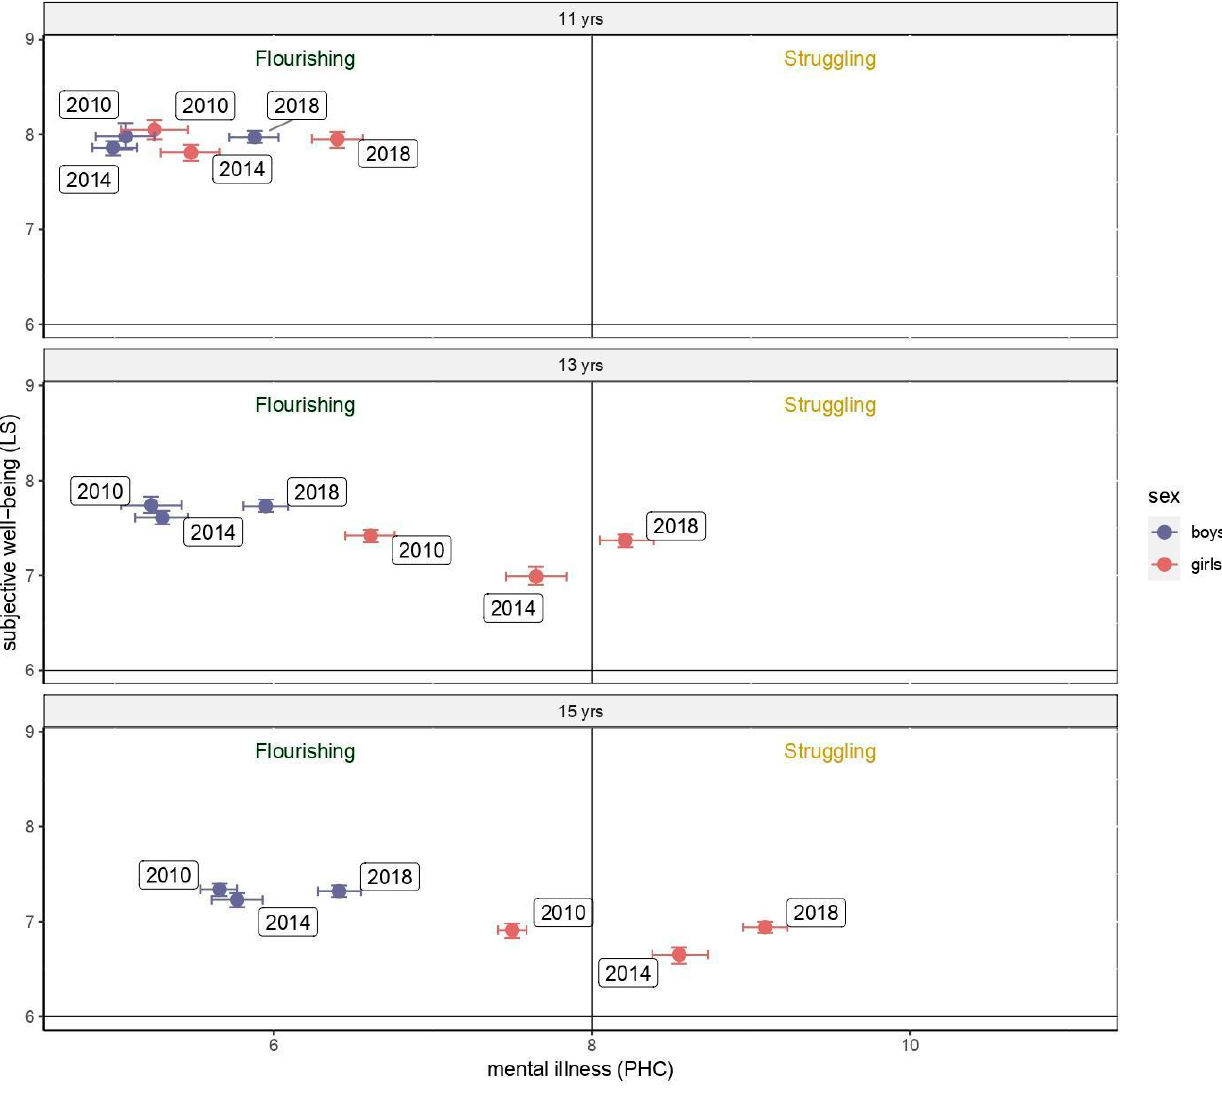
Figure 2. Change over time of the placement of the gender-age groups in the Dual Factor Model frame. PHC and LS as continuous variables. Abbreviations. LS: life satisfaction; PHC: psychological health complaints.